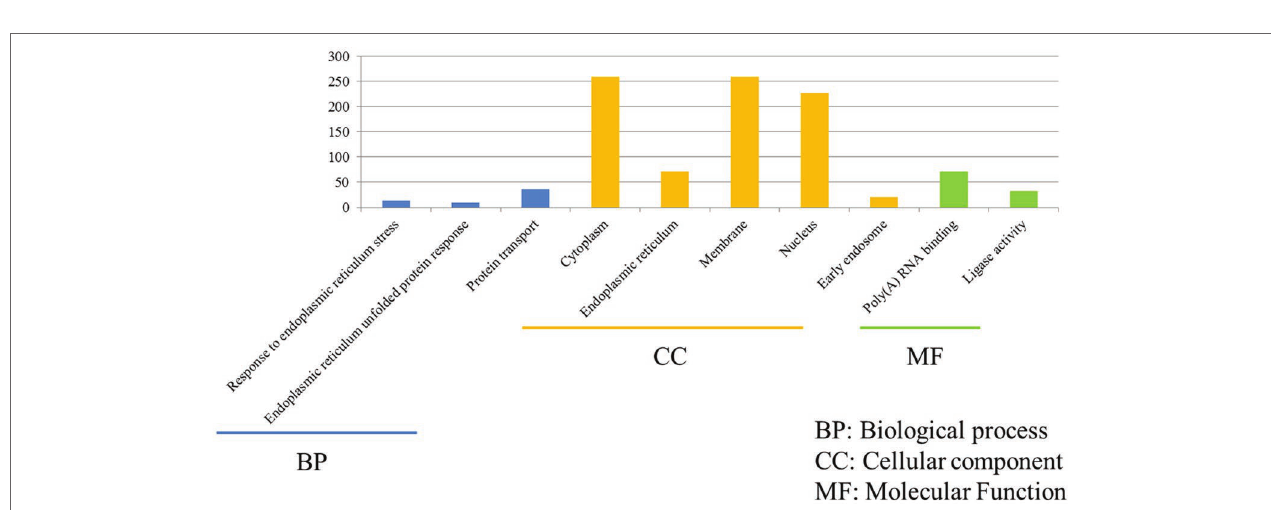
FIGURE 4 | Functional annotations and bioinformatic characterization of unique DEGs in P815 cells infected with H1N1 virus compared with H7N2 virus. (A,B) The GO biological process terms, GO cellular component terms and GO molecular function terms of unique DEGs in P815 cells infected with H1N1 virus and H7N2 virus were analyzed, respectively. Orange bar chart represented cellular classification of the IAV-regulated unique DEGs in P815 cells. Green bar chart represented molecular classification of the IAV-regulated unique DEGs in P815 cells. Blue bar chart represented biological classification of the IAV - regulated unique DEGs in P815 cells. Purple bar chart represented KEGG pathways of the IAV- regulated unique DEGs in P815 cells. (C) The regulation changes of DEGs involved in IAV signaling pathway. Red represented up-regulated DEGs. Yellow represented down-regulated